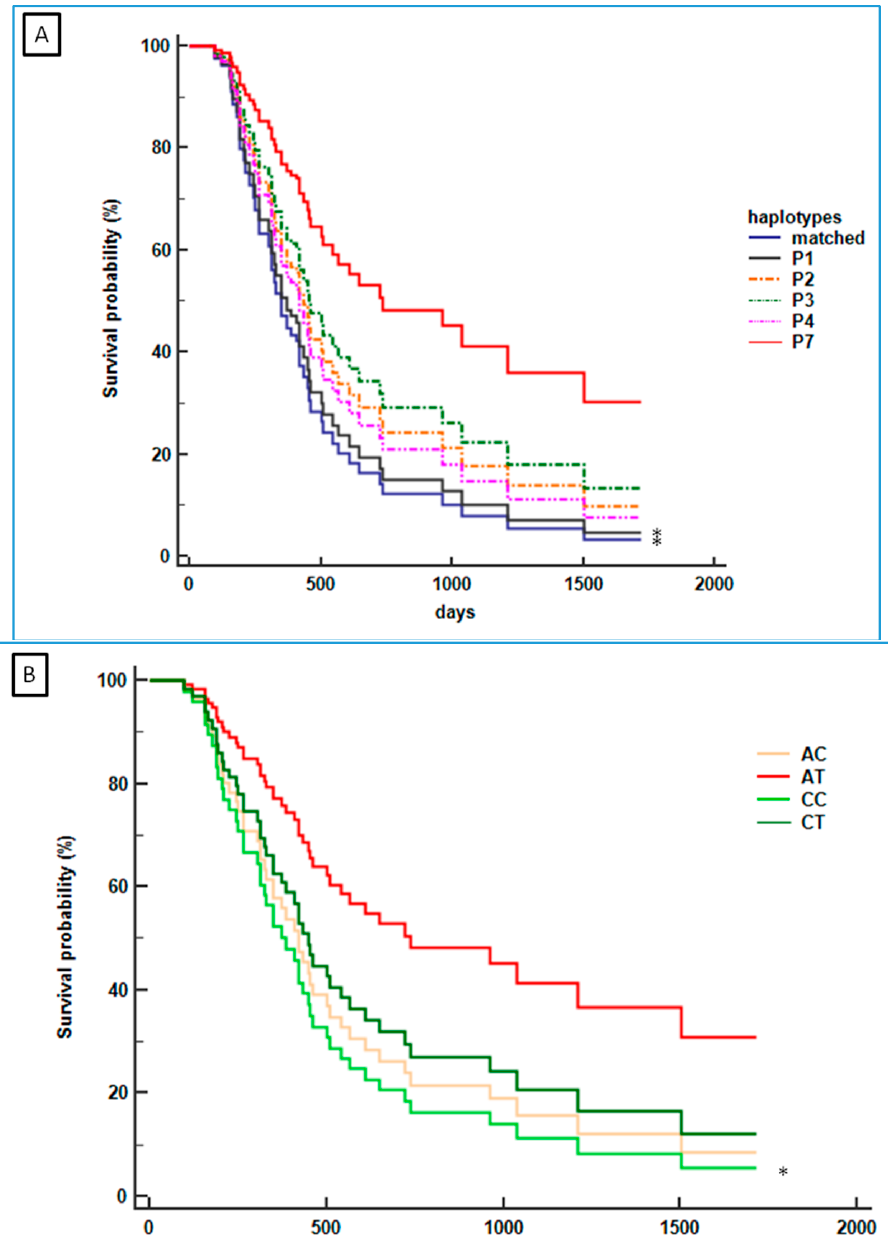
Figure 3. Cox regression for overall survival analysis according to the CDH1 haplotypes ( A ) and the restricted CDH1 haplotype model ( B ). ( A ) Overall survival curves of all patients with mGC ( n = 59) based on their different CDH1 haplotype; ( B ) Overall survival curves of all patients with mGC ( n = 59) according to coupled rs16260 and rs1801552 polymorphisms. * indicates a significant difference compared to the P7 haplotype (panel A ) and coupled AT polymorphism (panel B ).